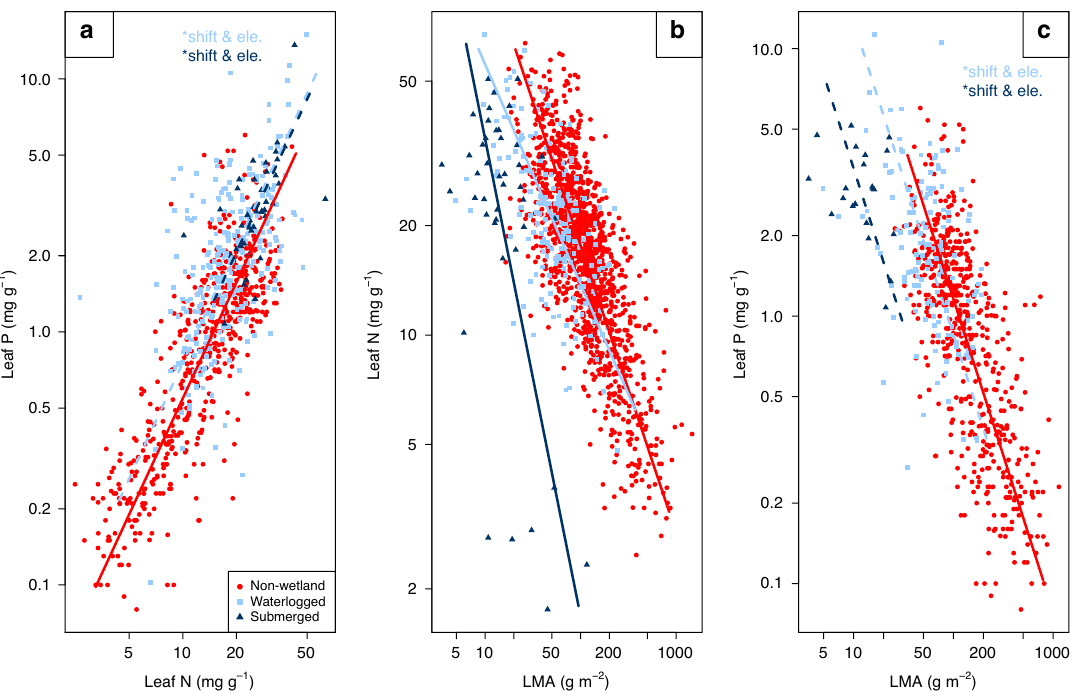
Fig. 1 The bivariate trait relationships between leaf P, N and LMA. a Leaf phosphorus (leaf P) vs leaf nitrogen (leaf N). b Leaf N vs. leaf dry mass per unit area (LMA). c Leaf P vs. LMA. The waterlogged and submerged wetland plants are shown in light blue squares and dark blue triangles, respectively. The non-wetland plant data from GLOPNET 3 are shown in red circles with a solid red line. If the slope for wetland plants differs signi fi cantly from that of non- wetland plants, this is indicated by a solid dark or light blue line, for waterlogged and submerged plants, respectively. Dashed lines with the notation of *shift and/or *ele . identify a signi fi cant shift along the common slope, and/or signi fi cant elevation differences among parallel slopes, respectively. Note that graph axes are log 10